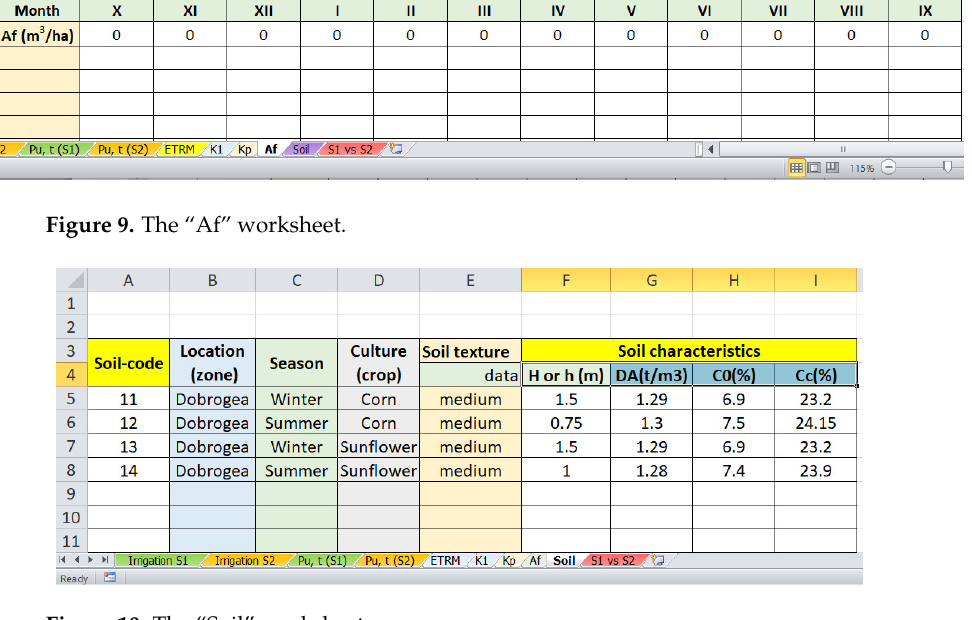
Figure 10. The “Soil” worksheet.